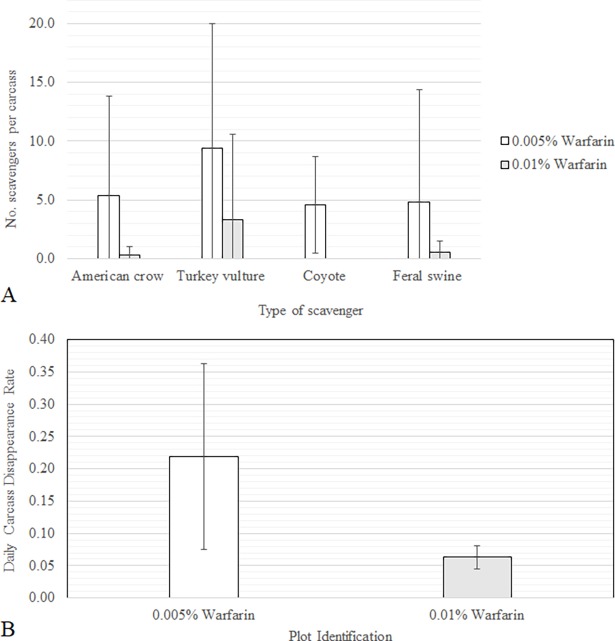
(A) The total number of non-targets observed on camera scavenging staged carcasses within each treatment plot; and (B) the mean days until disappearance of the carcasses within each treatment plot.